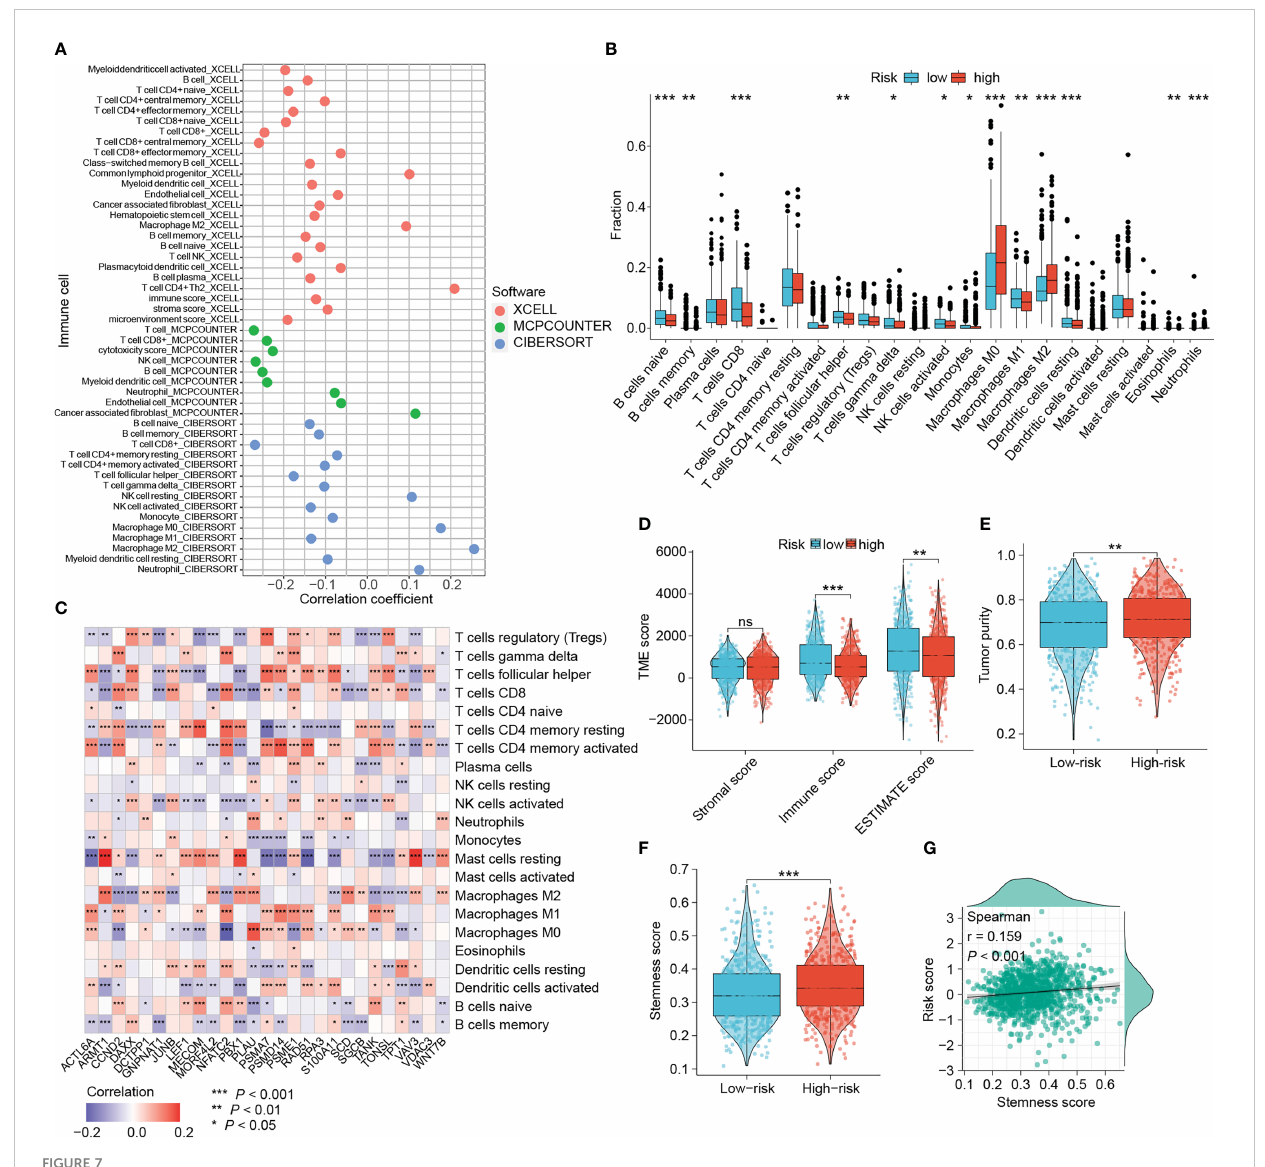
FIGURE 7 Dissection of the tumor microenvironment. (A) The correlation between the signature and tumor-in fi ltrating immune cells estimated by three algorithms. (B) Differential immune cells based on CIBERSORT algorithm between risk groups. (C) The relevance between the DRG expression and microenvironmental immune cells based on CIBERSORT algorithm. (D, E) Differences in microenvironmental scores and tumor purity. (F, G) Relationship between the signature score and tumor stemness. (ns: not signi fi cant, * P < 0.05, ** P < 0.01, *** P <